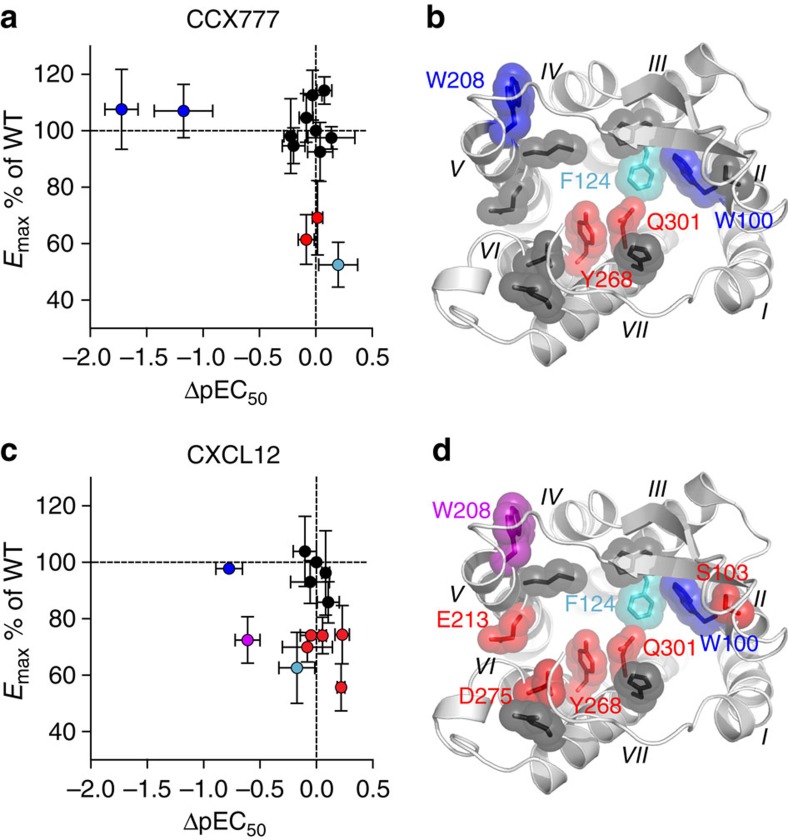
Functional characterization of orthosteric pocket mutants.(a,c) CCX777 and CXCL12 pEC50 and Emax values for ACKR3 mutants relative to WT-ACKR3. %Emax was determined as Emax,mutant/Emax,WT × 100 and ΔpEC50 as pEC50,mutant−pEC50,WT. Each data point represents the average and standard error of the mean of three or more independent experiments. (b,d) Mutants mapped onto the orthosteric pocket of a CXCR4-based homology model of ACKR3. Residues are coloured according to the plots in (a) and (c), with blue and red corresponding to decreased pEC50 values or lowered Emax, with respect to WT, respectively (P<0.05 from two-sided paired t-tests with n≥3). Residues that are unaffected by mutation are coloured in black, and W208, which has both decreased pEC50 and lowered Emax with CXCL12, shown in purple. F124A (cyan) is different from all other mutants in showing a reduced surface expression (60% of WT ACKR3) at virtually unchanged total expression (Supplementary Fig. 6). This may complicate the interpretation of the BRET data and contribute to the reduced Emax values. See Supplementary Table 5 for the identities, sample sizes and pEC50 and Emax values for all mutants.